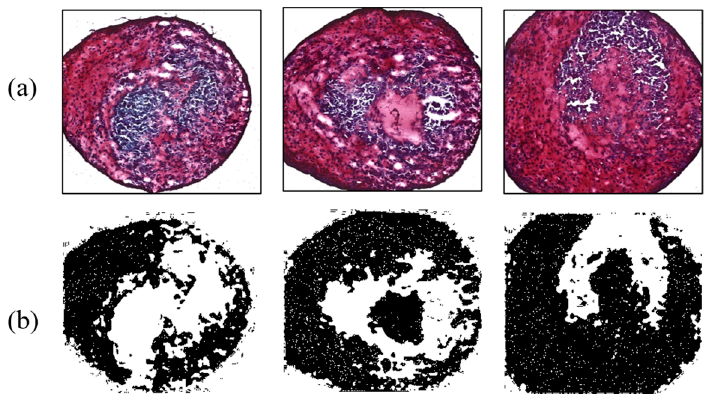
Figure 10. Enhanced chondrogenesis for the round tip. ( a ) Safranin-O-stained MSCs; ( b ) ImageJ results.